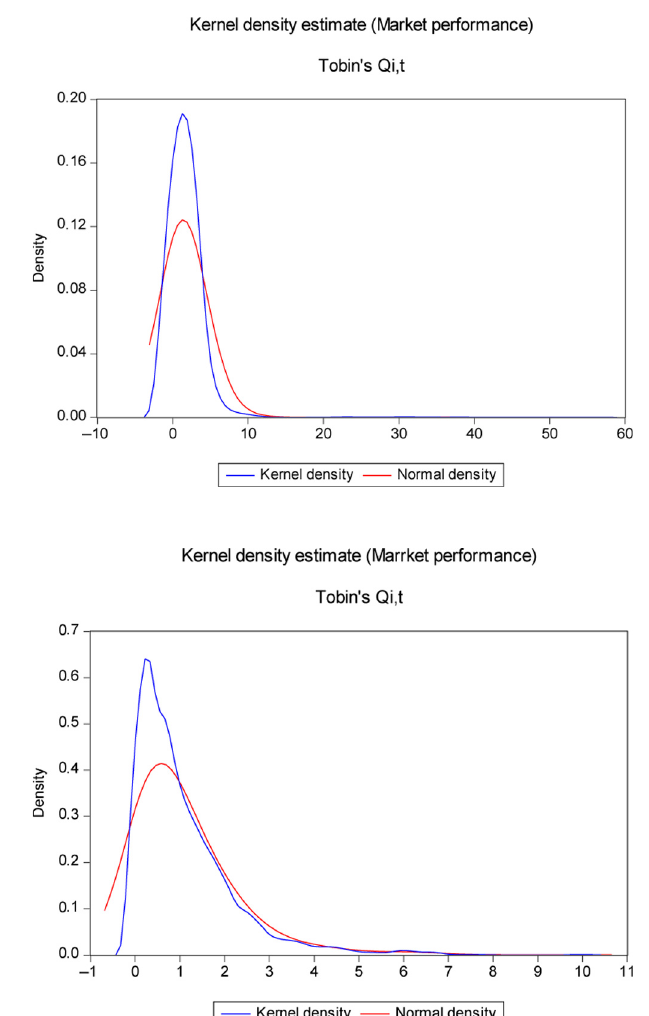
Figure 12. Non-normality of market